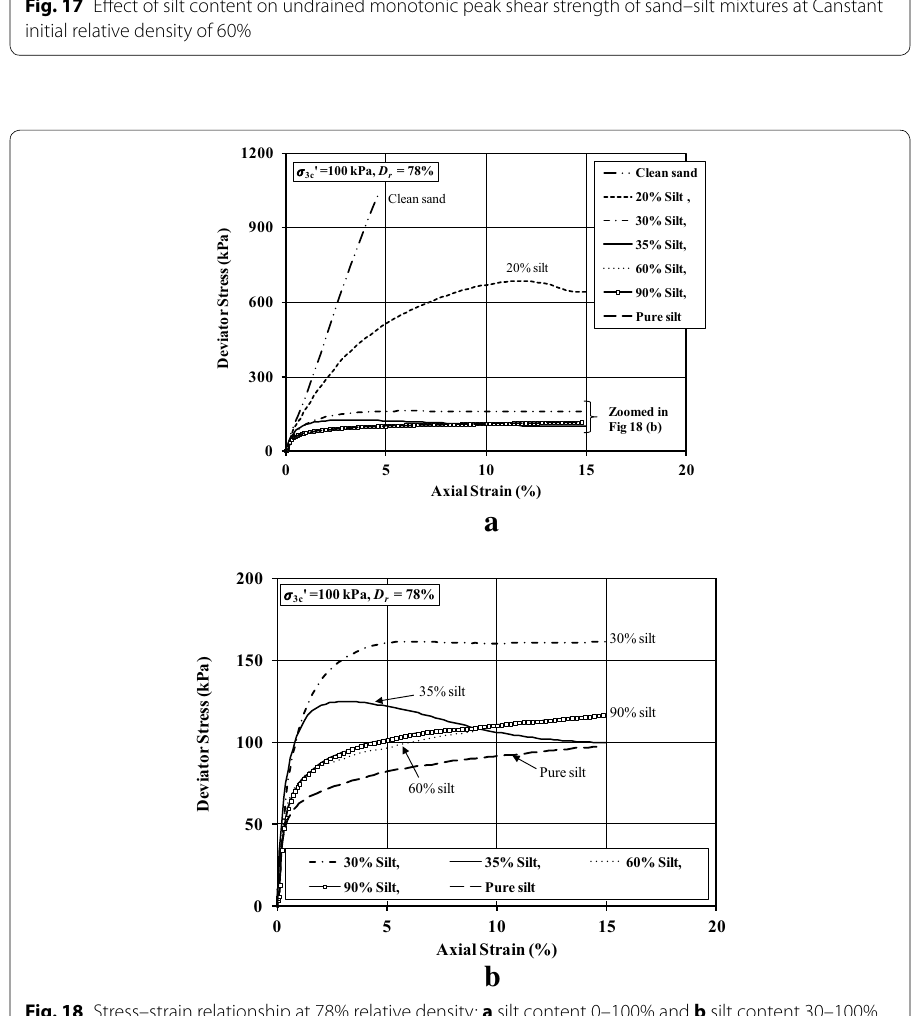
Fig. 18 Stress–strain relationship at 78% relative density; a silt content 0–100% and b silt content 30–100%